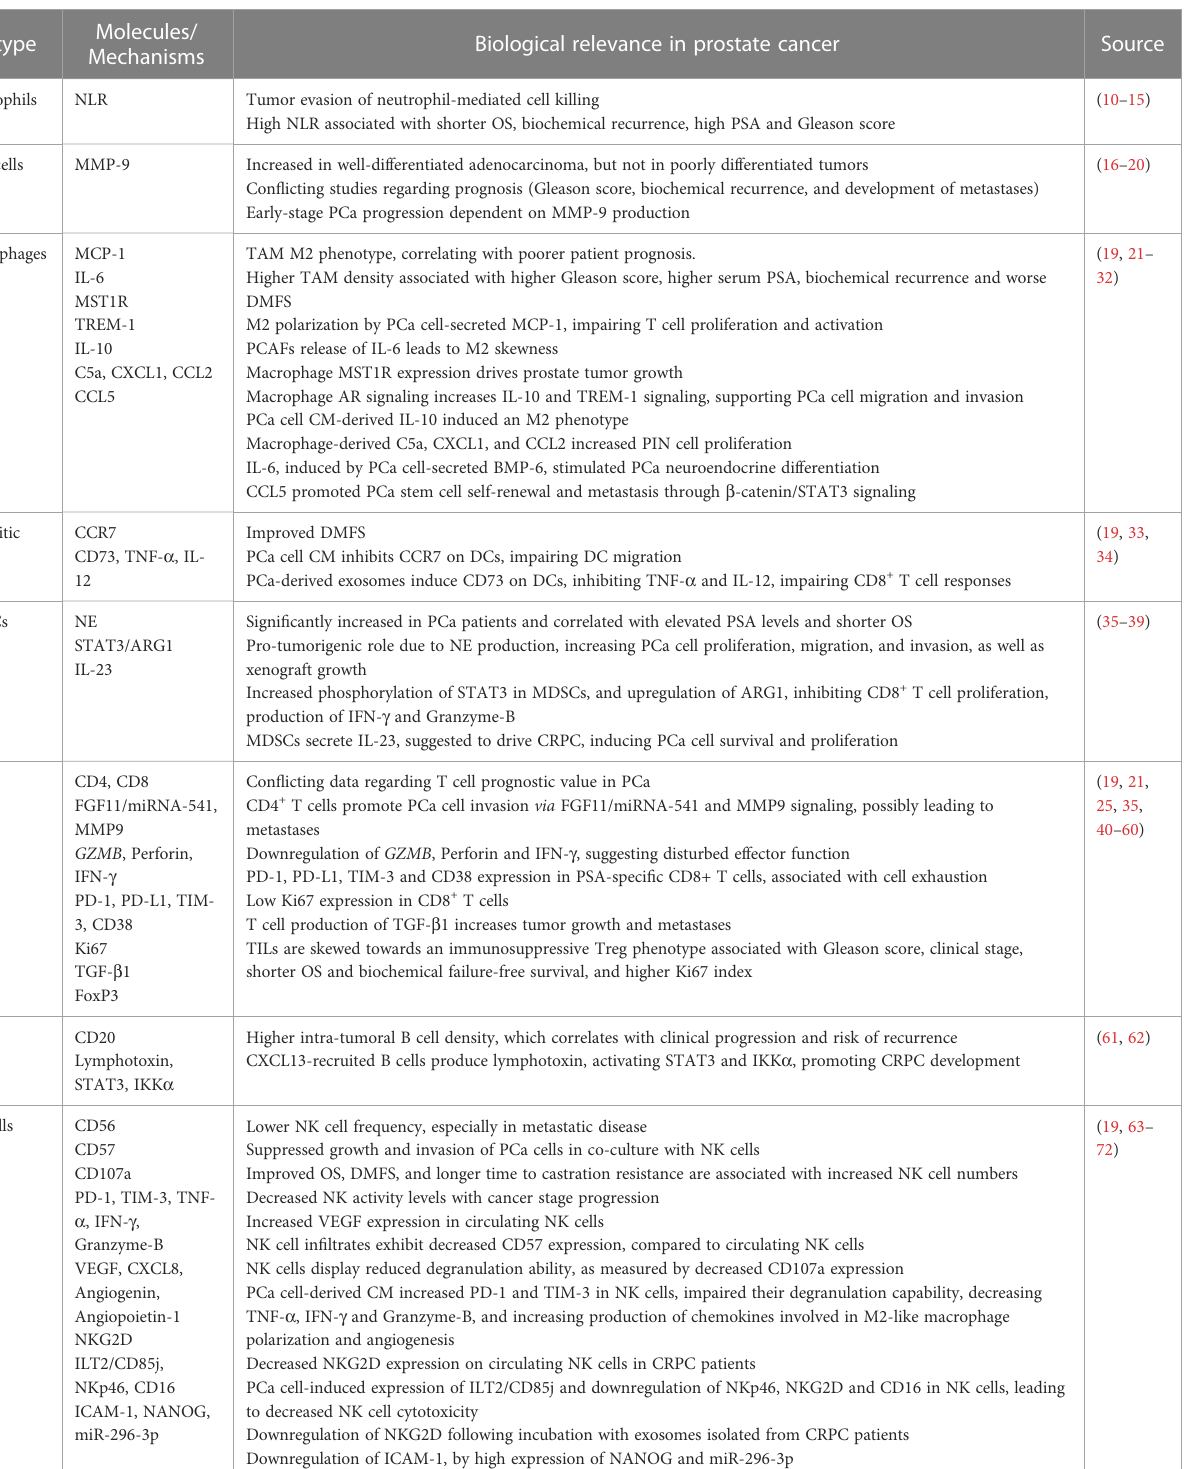
TABLE 1 Summary of the immune cell landscape in